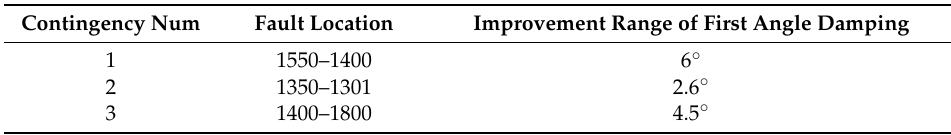
Table 2. The effect of the first power control scheme in other